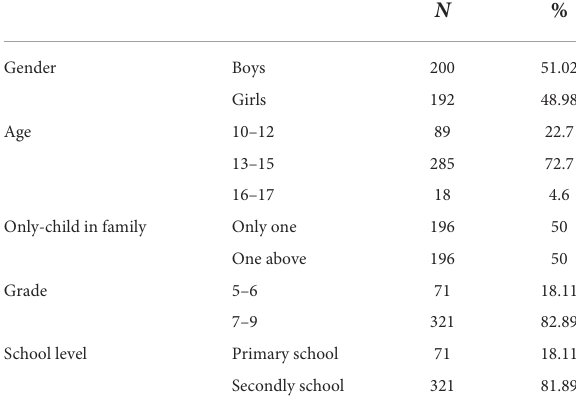
TABLE 1 Demographic information of